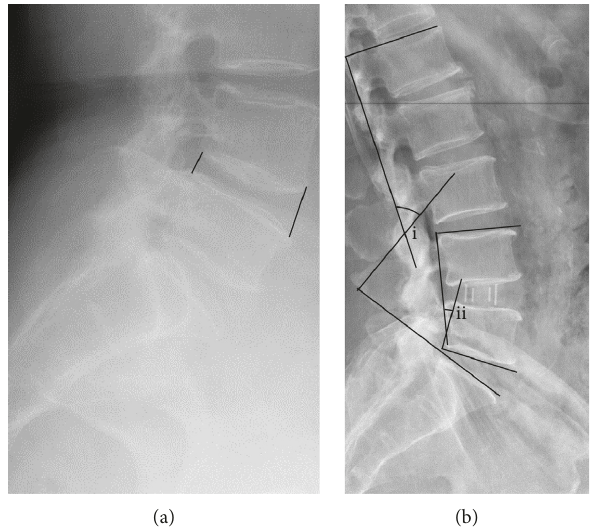
Figure 2: Measurement method. (a) Measurement diagram of intervertebral disc height; (b) the whole lumbar lordotic angle (i) and the operative segmental lordotic angle